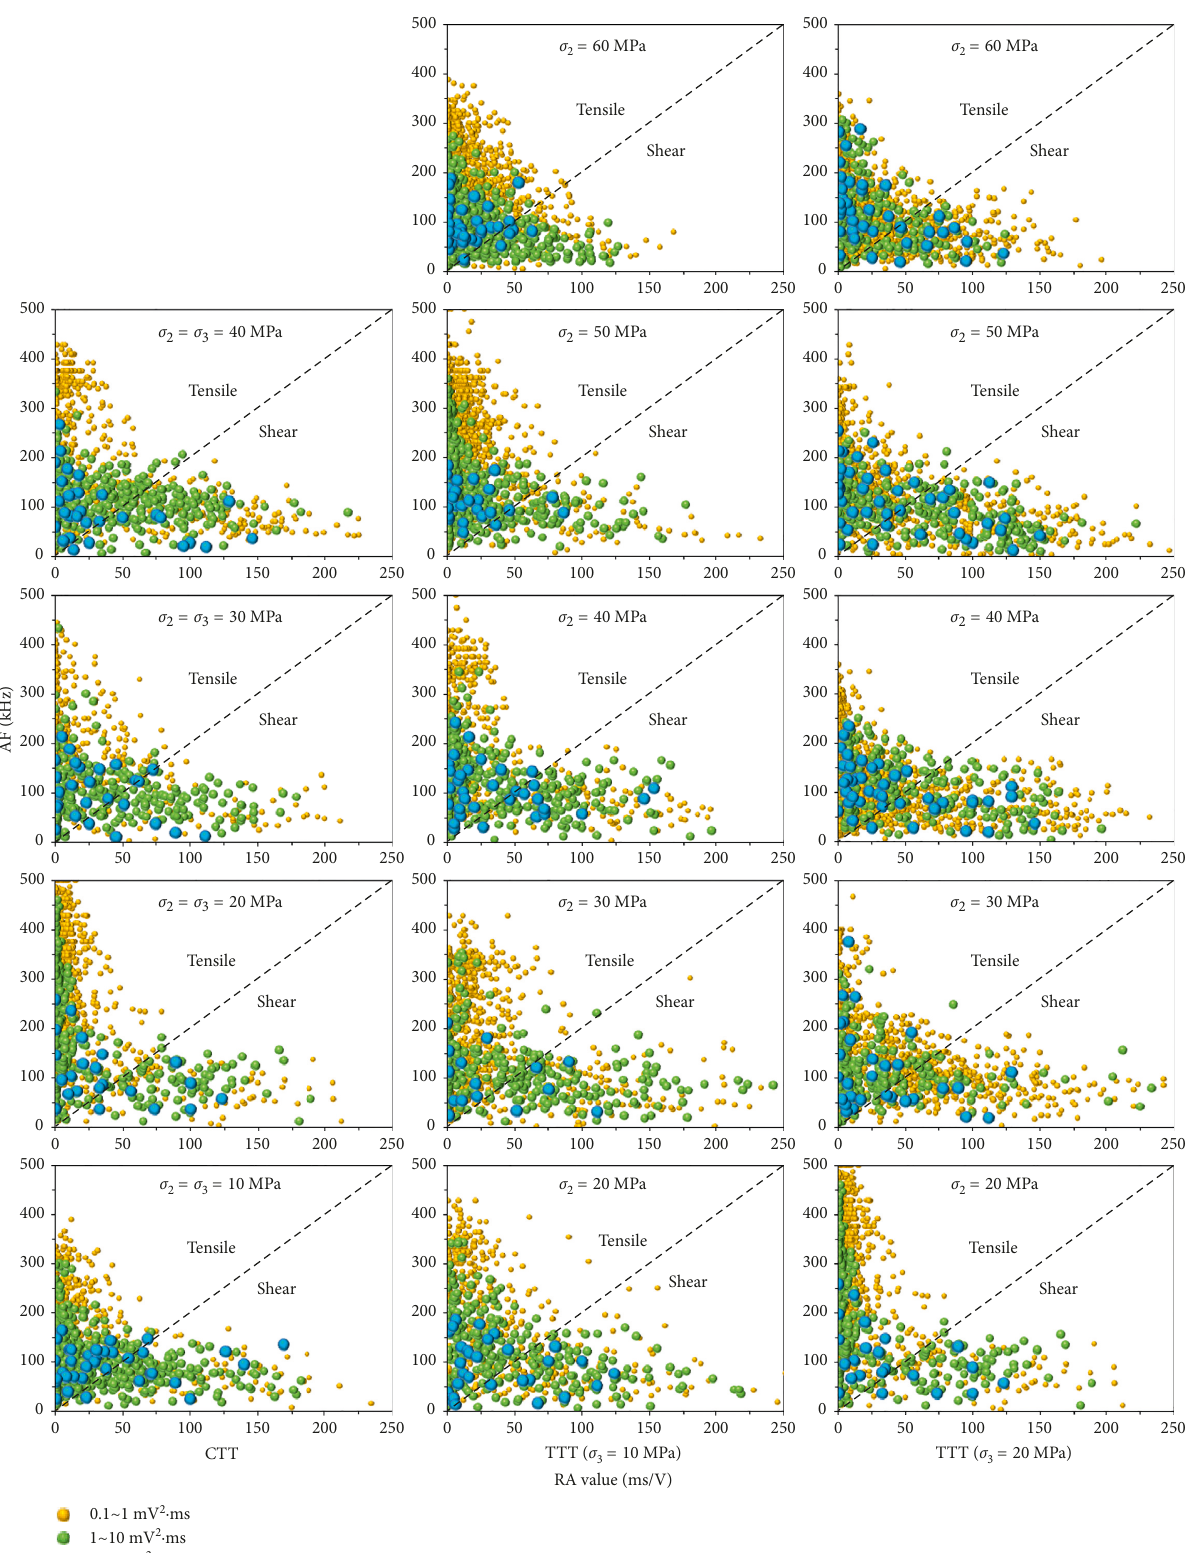
Figure 15: Variation of the RA and AF values under different loading